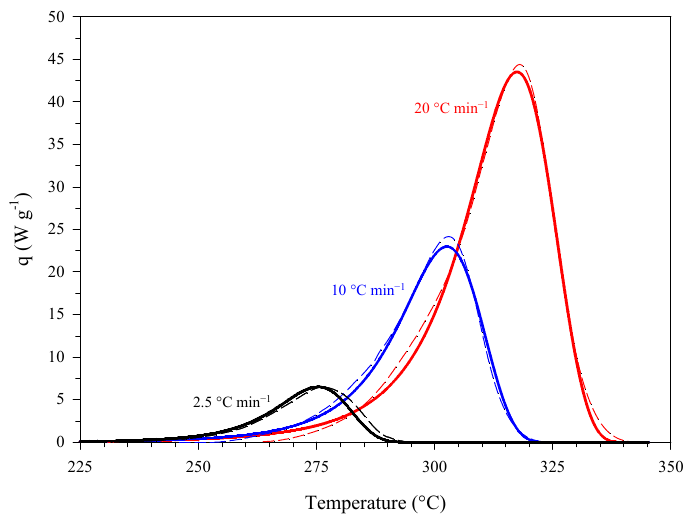
Figure 5. Specific heat power curves at different heating rates: DSC data of Figure 2 (mean data, dashed lines) and corresponding kinetic predictions (solid